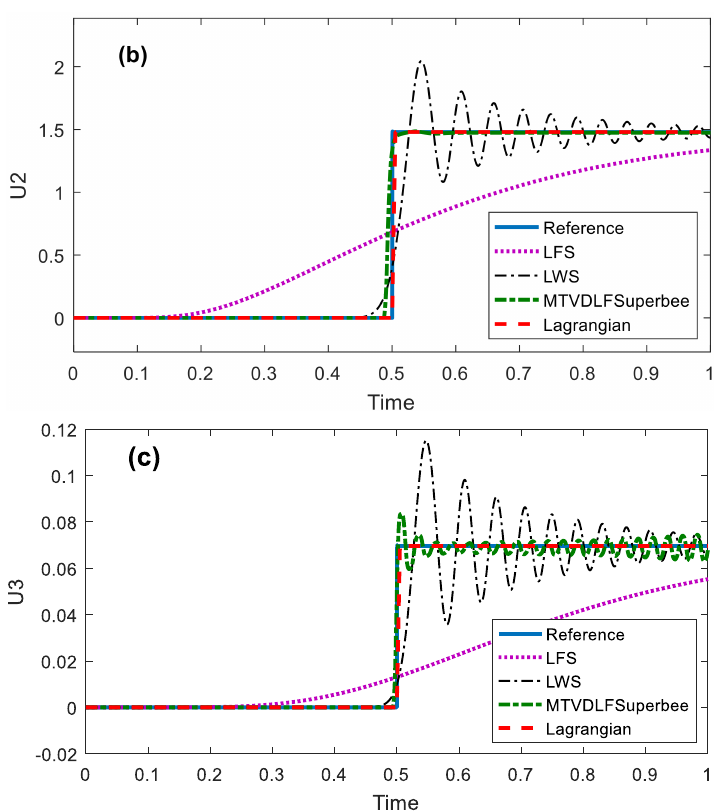
Figure 2. Comparisons of numerical methods for autocatalytic reaction model with three-component reactants at 𝑋 = 0.5 . Time change of concentration for ( a ) species A, ( b ) species B and ( c ) species C.